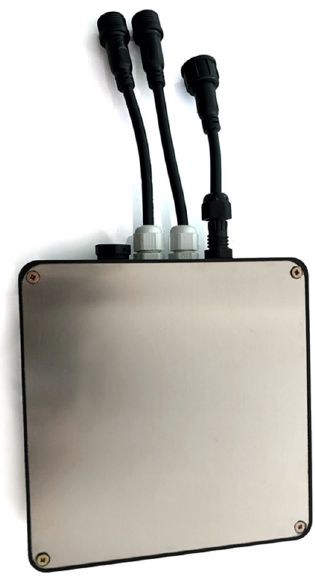
Figure 3. Central unit of the measurement module.